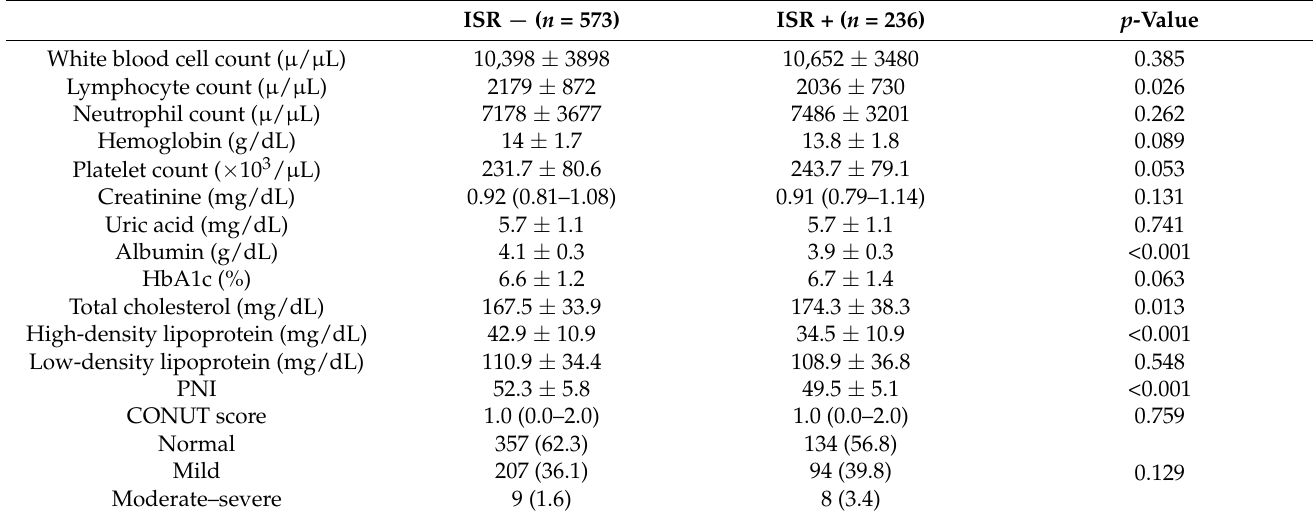
Table 2. Comparison of the laboratory measurements in the patient groups.